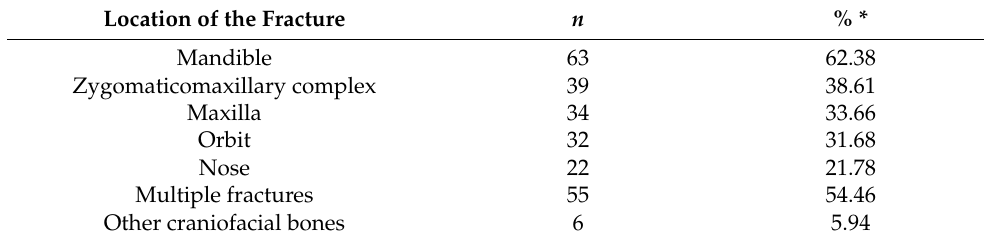
Table 4. Location of the